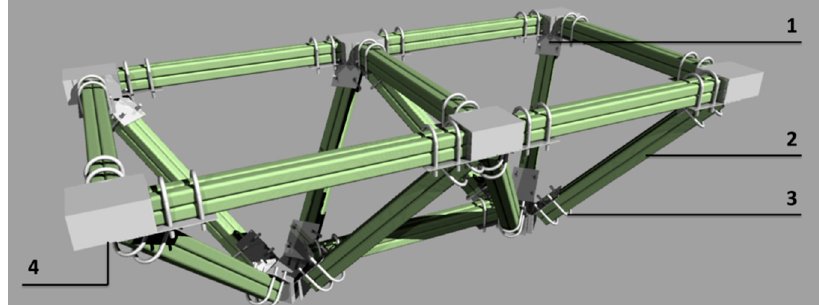
Figure 3. Date palm midribs square pyramid space truss (reproduced from [22]). (1) Steel plate. (2) Space truss element made from pressed midribs strips. (3) U-shaped high strength bolts. (4) Steel box connectors.